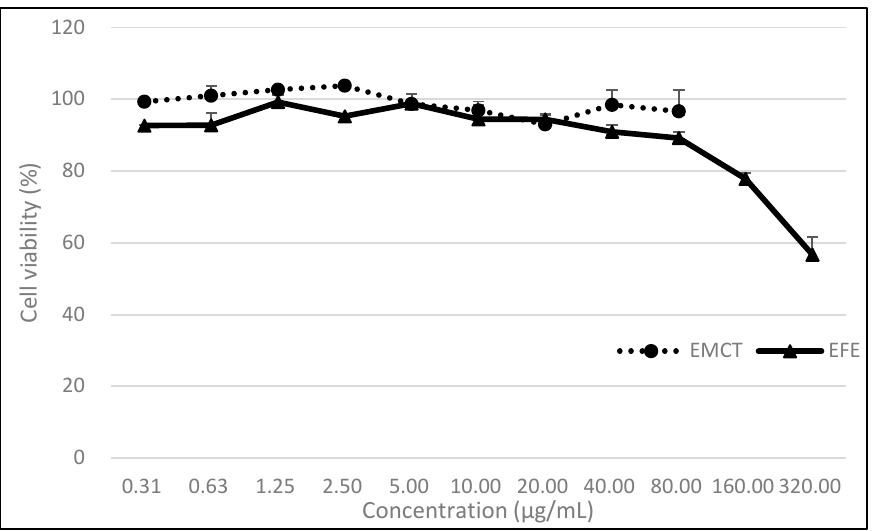
Figure 1. Cell viability under EFE or EMCT treatment. Seeded cells were treated with EFE or EMCT at the indicated concentrations and incubated for 24 h. Cell counts were compared to those of the control (0 µ g/mL) and % viabilities are mean ± standard deviations of two independent